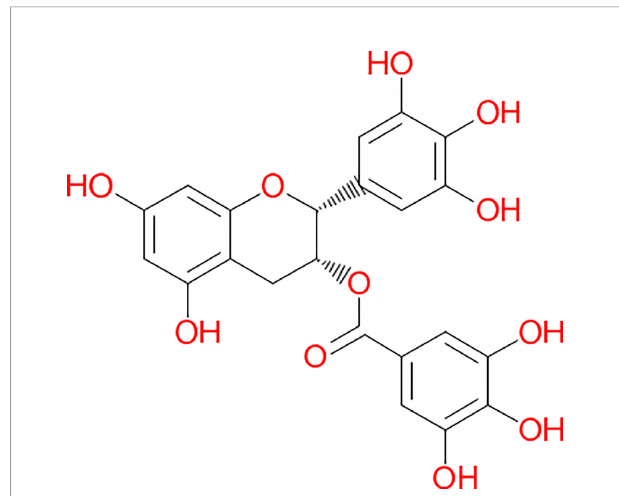
FIGURE 2 | Chemical structure of (-)-Epigallocatechin-3-gallate. This structure was derived by the application of the software Chem4Word 3.0, United